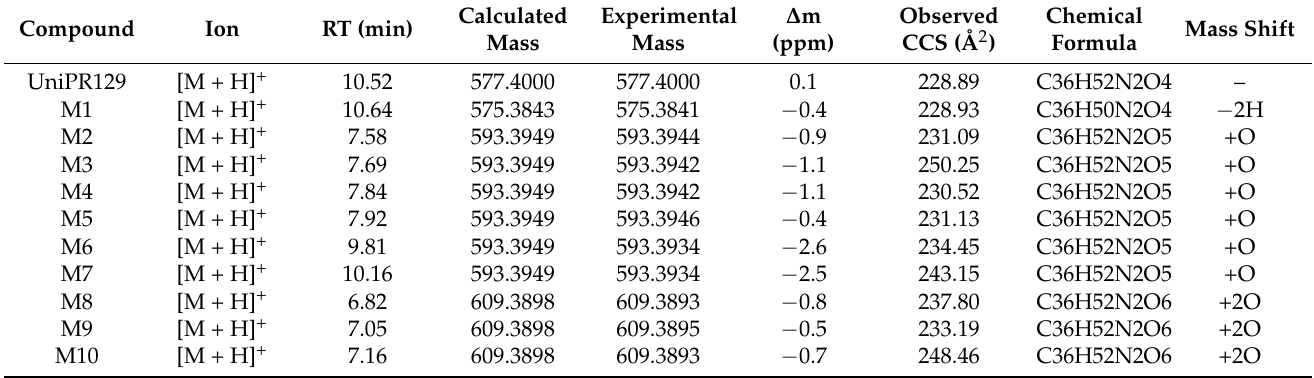
Table 1. Phase I putative metabolites of UniPR129 in mouse liver